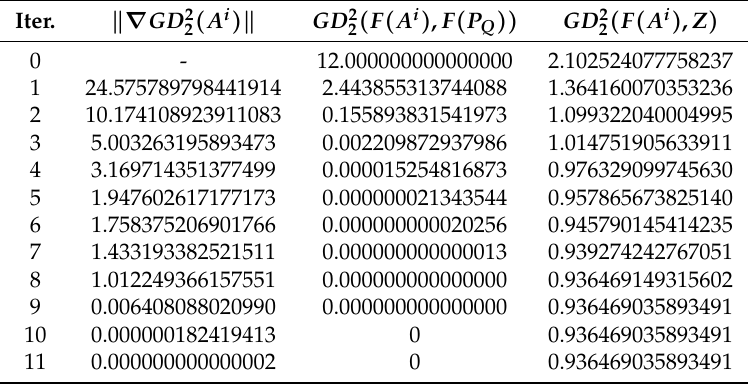
-Newton method for BOP 2